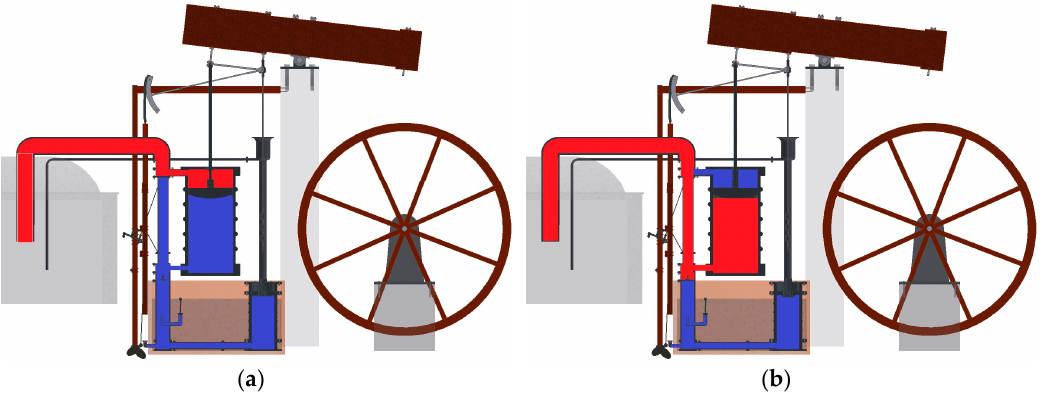
Figure 3. Movement of water vapor in the hydropneumatic system: ( a ) downward movement of the piston; ( b ) upward movement of the piston.